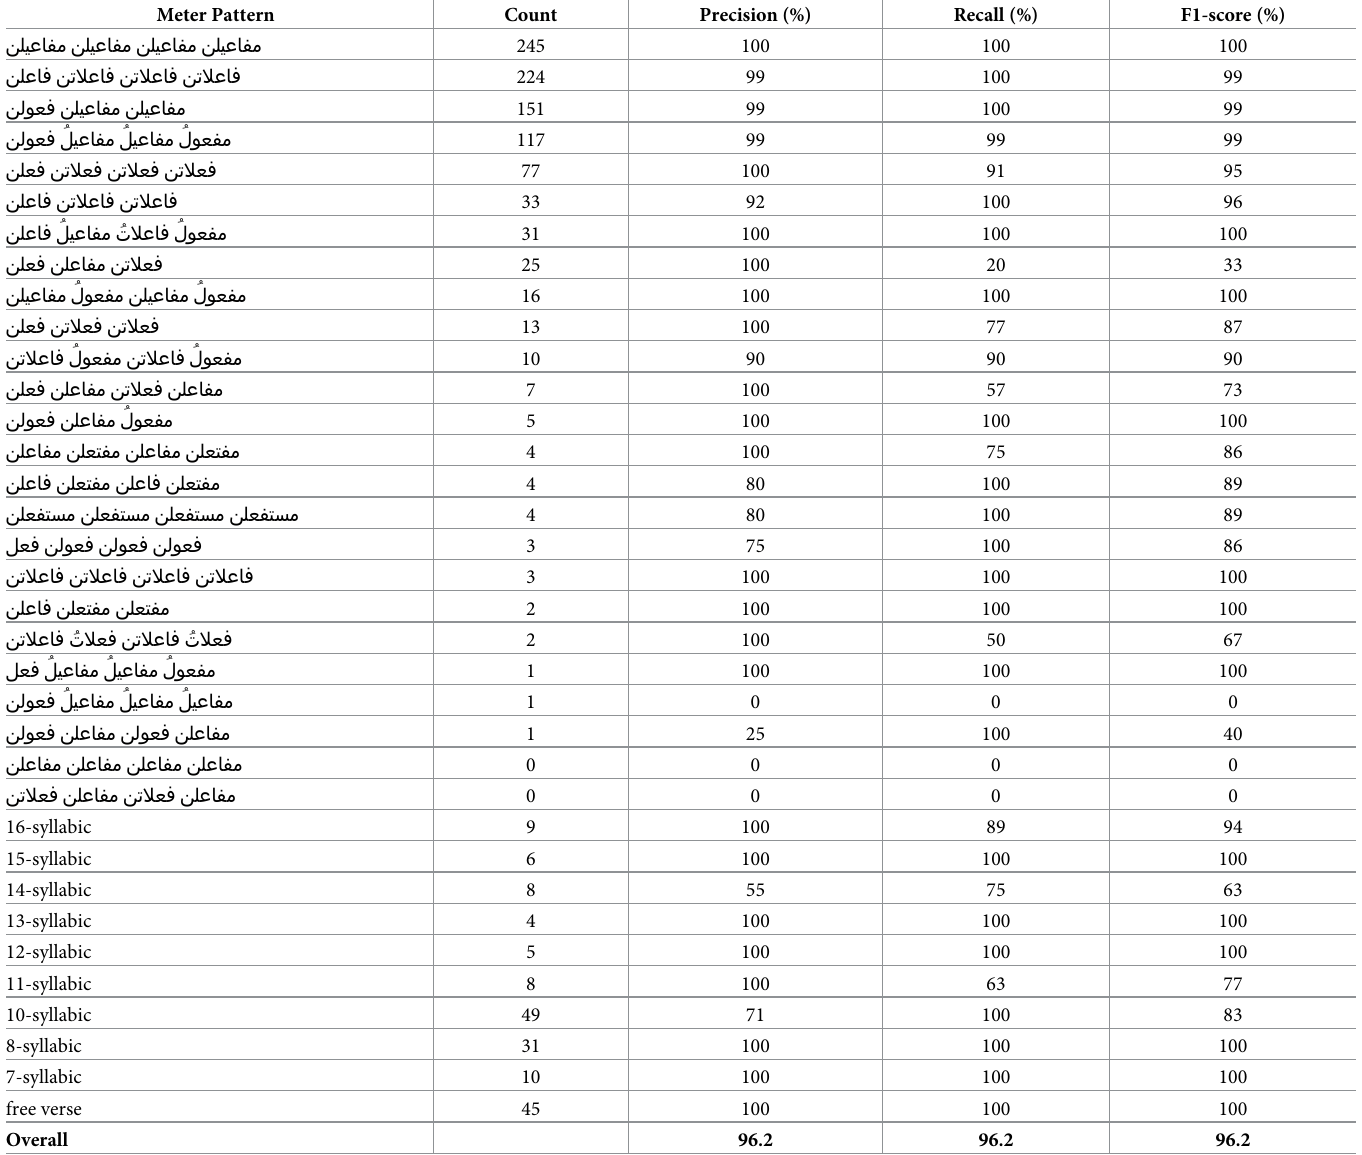
Table 8. Meter pattern classification results, separated by